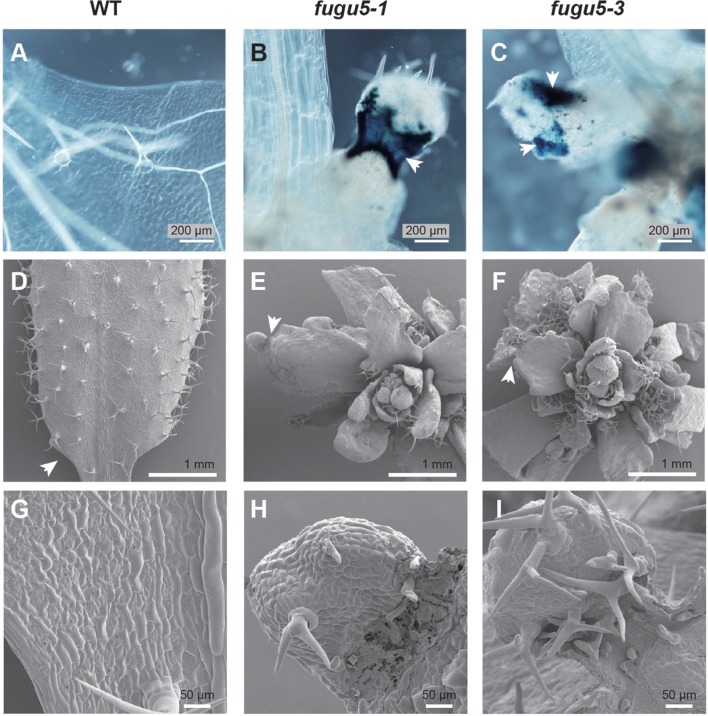
Cell viability test with trypan blue shows cell death in the basal regions of leaves of fugu5 grown on MGRL culture medium. WT, fugu5-1, and fugu5-3 plants were grown on MGRL plates for 2 weeks (A-C) or 3 weeks (D-I). The rosette leaves of WT (A), fugu5-1
(B), and fugu5-3
(C) were stained with trypan blue to test cell viability, as described in the Materials and Methods section. Arrowheads in (B,C) indicate the regions stained with trypan blue, where necrosis occurred. The rosette leaves of WT (D,G), fugu5-1
(E,H), and fugu5-3
(F,I) plants were observed by scanning electron microscopy. Arrows in (D-F) indicate the basal regions (leaf blade–petiole junctions) of the rosette leaves, with enlarged images shown in the lower panels (G-I).